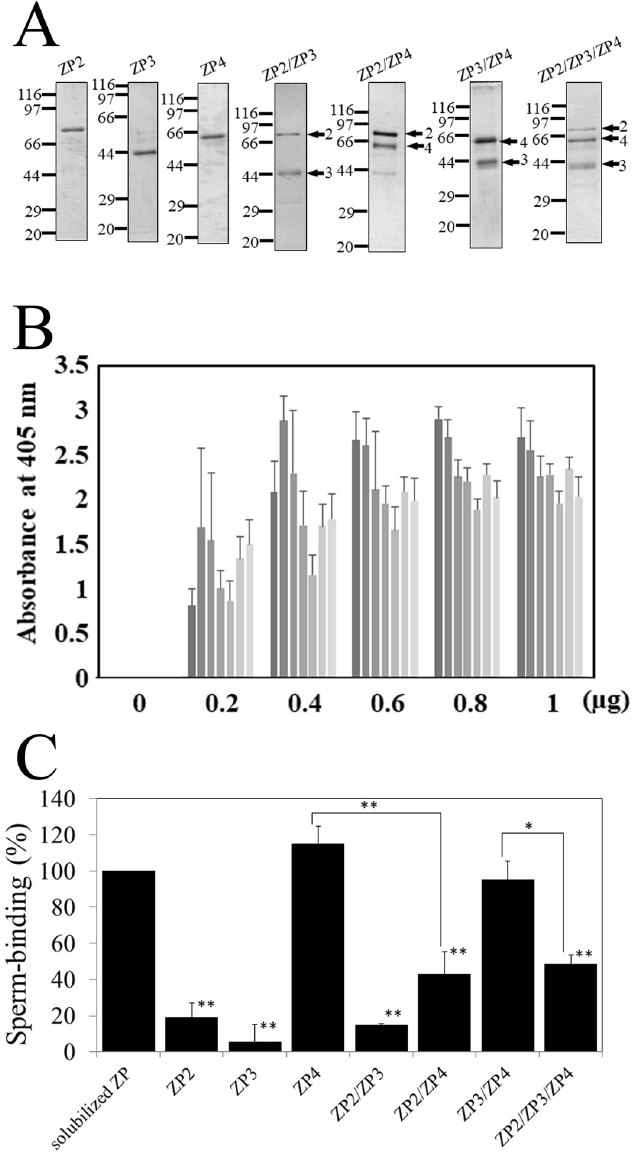
Fig 2. Sperm-binding activity of bovine ZP proteins in a solid supported form. (A) Sodium dodecyl sulfate polyacrylamide gel electrophoresis (SDS-PAGE) of recombinant bovine ZP proteins. Each single component of bovine ZP, ZP2, ZP3, and ZP4; combinations of two components, ZP2/ZP3, ZP2/ZP4, and ZP3/ZP4; and combinations of all three components, ZP2/ZP3/ZP4; were expressed in Sf9 cells by infecting the corresponding baculoviruses and partially purified using TALON resin specific to the His-tag. SDS-PAGE of elution fractions are shown. Gels were silver-stained. Molecular mass standards (kDa) are indicated on the left side of each panel. In the gels loaded with two or three component mixtures, each band is shown by an arrow with a number (ZP2:2, ZP3:3, and ZP4:4). (B) Adsorption of recombinant bovine ZP proteins to plastic wells. The amount of each recombinant ZP protein or mixture added to one plastic well is indicated under each group of bars. The amount of proteins necessary for adsorption saturation was examined by detecting the adsorbed proteins with antibodies specific to N-terminal His-tag and N-terminal FLAG-tag. The experiment was performed three times and average ± standard deviation (SD) of absorbance at 405 nm is shown. The amounts of ZP2, ZP3, ZP4, ZP2/ZP3, ZP2/ZP4, ZP3/ZP4, and ZP2/ZP3/ZP4 adsorbed to plastic wells are shown by bars with the gradation from dark gray (left) to light gray (right), respectively, in each group of seven bars. (C) Sperm-binding activity of bovine ZP proteins. Plastic wells were coated with the ZP proteins indicated in the graph. The number of sperm bound to wells coated with solubilized native ZP varied from 28 to 72 among experiments but was designated as 100% at each experiment. Assays were repeated at least three times. Data are presented as the mean ± SD, with statistical significance relative to “solubilized ZP” indicated as P < 0.01 ( �� )